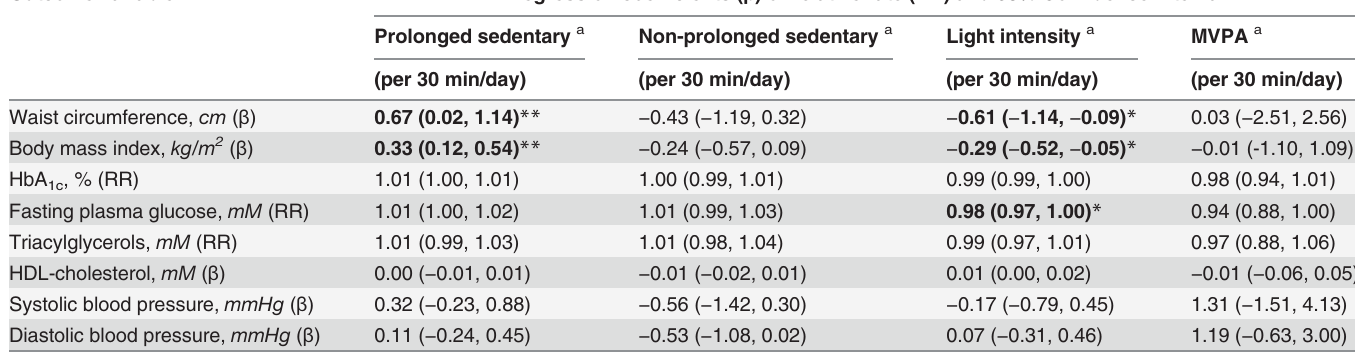
Table 2. Cross-sectional associations (Model 1) of each 30 minutes per day of prolonged sedentary, non-prolonged sedentary, light intensity activity and moderate to vigorous intensity activity (MVPA) with continuous cardio-metabolic biomarkers in n = 279 overweight/obese adults with type 2